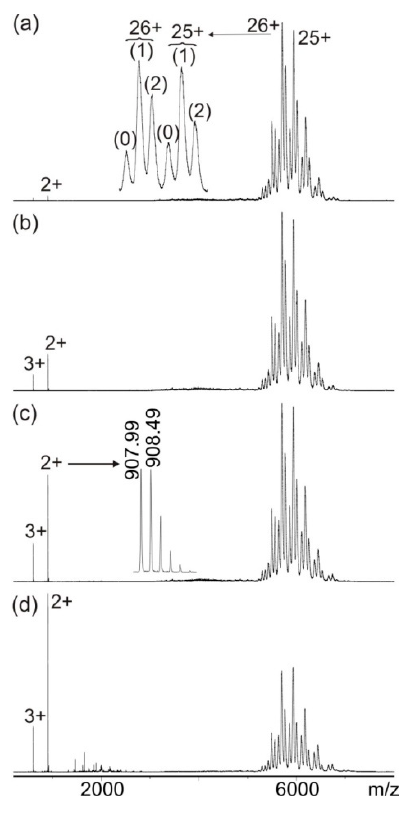
Figure 1. Nano-ESI mass spectra of peptide 1 (ENREVGDWRKNIDAL)—anti-hcTn I antibody immune complex with increasing collision cell voltage differences ( ∆ CV): ( a ) 4 V, ( b ) 16 V, ( c ) 30 V, and ( d ) 80 V. Charge states are given for the immune complexes (right ion series), and the inlet in ( a ) shows a zoom of the 25+ and 26+ ion signals of the antibody (0) and the immune complexes (antibody plus one peptide (1) and antibody plus two peptides (2)). Charge states and m/z values for peptide ion signals are given on the left, and the inlet in ( c ) shows a zoom of the isotopically resolved doubly protonated peptide ion signal. Antibody fragment ion signals are visible between m/z 1200 and m/z 2300 in ( d ). Solvent: 200 mM ammonium acetate, pH 6.7.